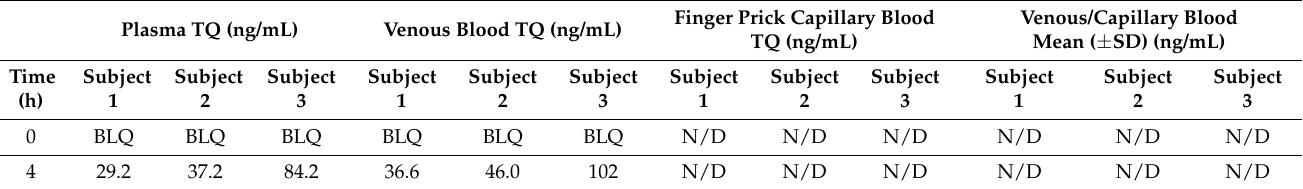
Table 3. Plasma, venous blood and finger prick capillary blood concentrations of TQ from subjects given an oral dose of 200 mg TQ ( n = 3). Capillary blood samples were taken at 12, 24, 96 and 168 h after dosing. Venous/Capillary blood mean values with SD also shown. SD, Standard Deviation; LLOQ, Lower Limit of Quantification (1 ng/mL); N/D, No Data. Venous Blood TQ